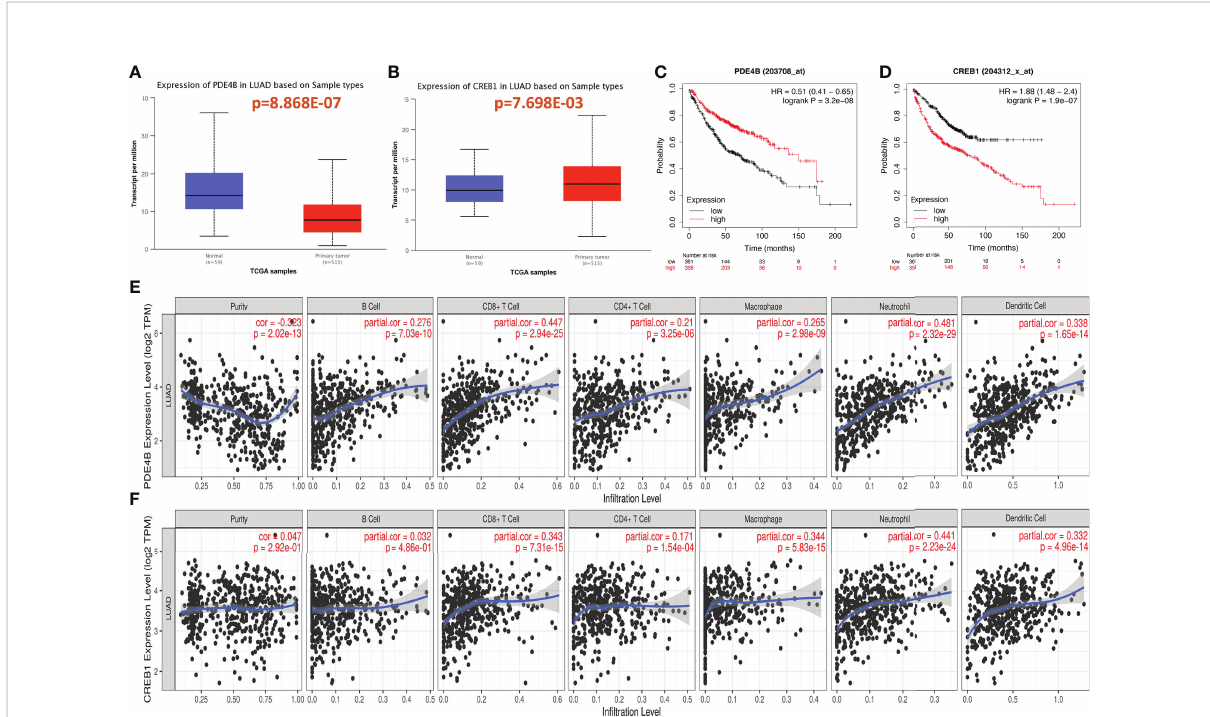
FIGURE 1 Expression of cAMP/PDE4 pathway genes and its effect on prognosis and immune in fi ltration in lung adenocarcinoma. (A, B) : Differential expression of PDE4B and CREB1 in lung adenocarcinoma and normal control tissues. (C, D) : PDE4B and CREB1 were analyzed for prognosis using the Kaplan – Meier plotter database. (E, F) : PDE4B and CREB1 were analyzed for immune in fi ltration using the TIMER database in